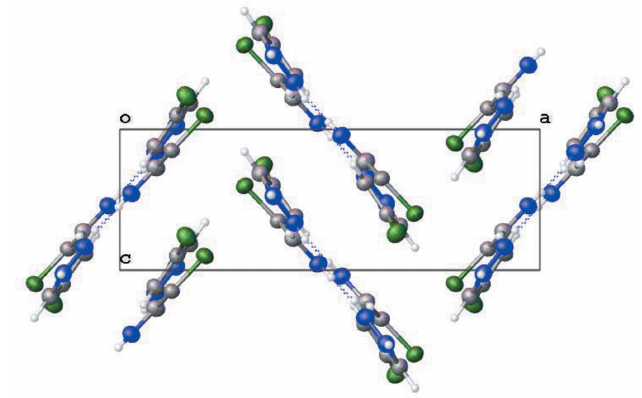
Figure 2 Packing of 4-chloro-1 H -pyrazole, viewed parallel to the c axis, showing the formation of trimeric units. Half the disordered protons have been removed for clarity.